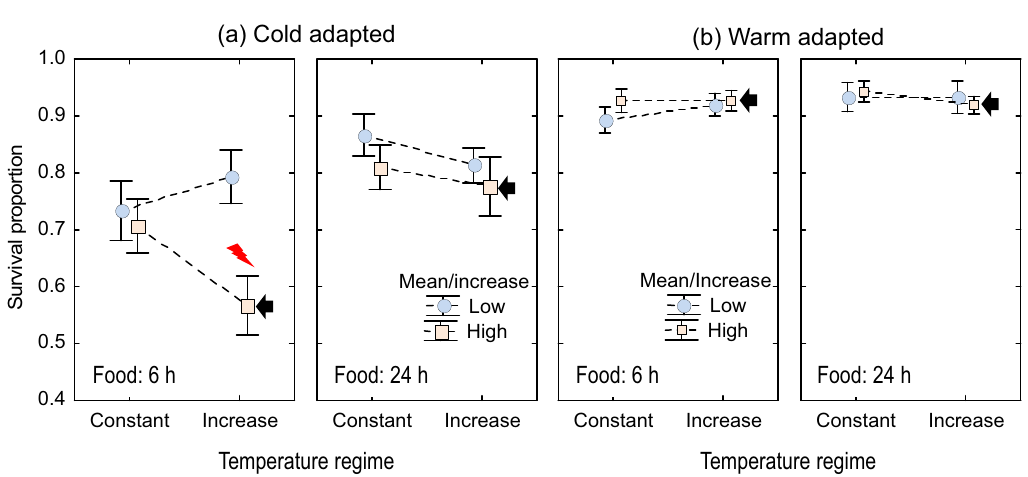
Fig. 5 Interaction plots of the effect of simulated heatwaves on larval survival. Survival was quanti fi ed in ( a ) the native cold-adapted ( Carcinus maenas ) and ( b ) warm-adapted crab ( Hemigrapsus sanguineus ) reared in seawater under food limitation or ad libitum food conditions. The black arrow indicates the “ heatwave treatment ” and the red thunder in ( a ) indicates signi fi cant difference between the simulated heatwave (high mean and high rate of temperature increase) and the remaining treatments. Means are the overall mean (data from 3 females pooled) and error bars are standard errors ( n = 15). The full set of plots of responses discriminated by female of origin and including low salinity treatments are shown in Supplementary Figs. 7 and 8.